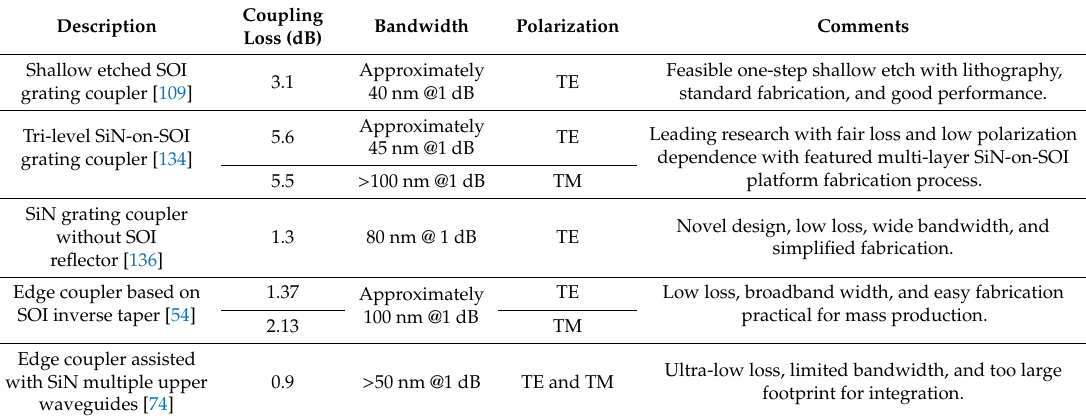
Table 3. Comparison of coupler performance in multilayer SiN platforms and silicon-on-insulator (SOI)